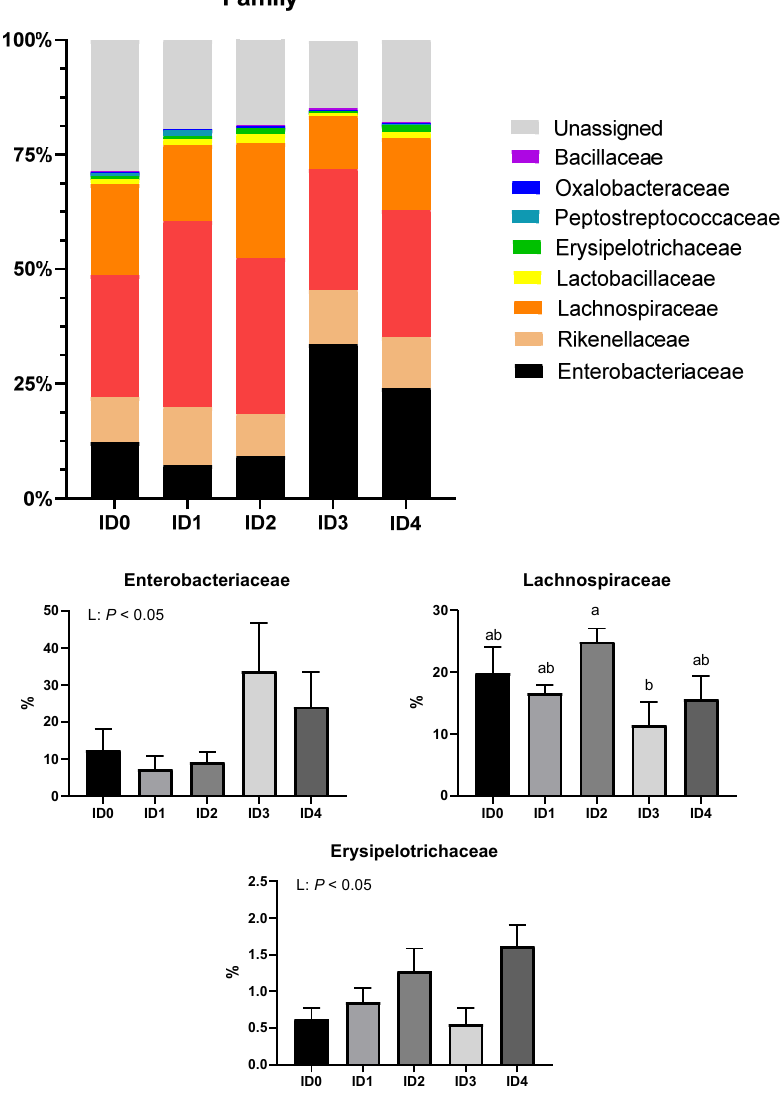
Figure 5. Effects of different infection doses of Eimeria tenella on family-level composition of the cecal microbial communities in broilers 6 days post-infection. Phylum-level composition was measured in the ID0 (infection dose 0; sham-challenged with phosphate-buffered saline); ID1 (infection dose 1; challenged with 6250 sporulated oocysts of Eimeria tenella ); ID2 (infection dose 2; challenged with 12,500 sporulated oocysts of E. tenella ); ID3 (infection dose 3; challenged with 25,000 sporulated oocysts of E. tenella ); ID4 (infection dose 4; challenged with 50,000 sporulated oocysts of E. tenella ) groups. Data were analyzed by using One-way ANOVA followed by the Tukey’s multiple comparison test and means with different letters (a and b) differ significantly ( p < 0.05). Orthogonal polynomial contrast analysis was used to assess linear (L) and quadratic (Q) effects of the infection doses, and p < 0.1 were